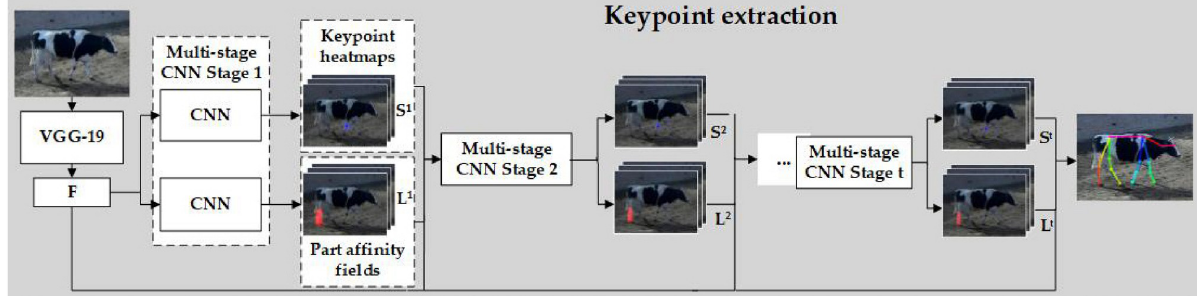
Fig 3. The structure of two-branch skeleton extraction